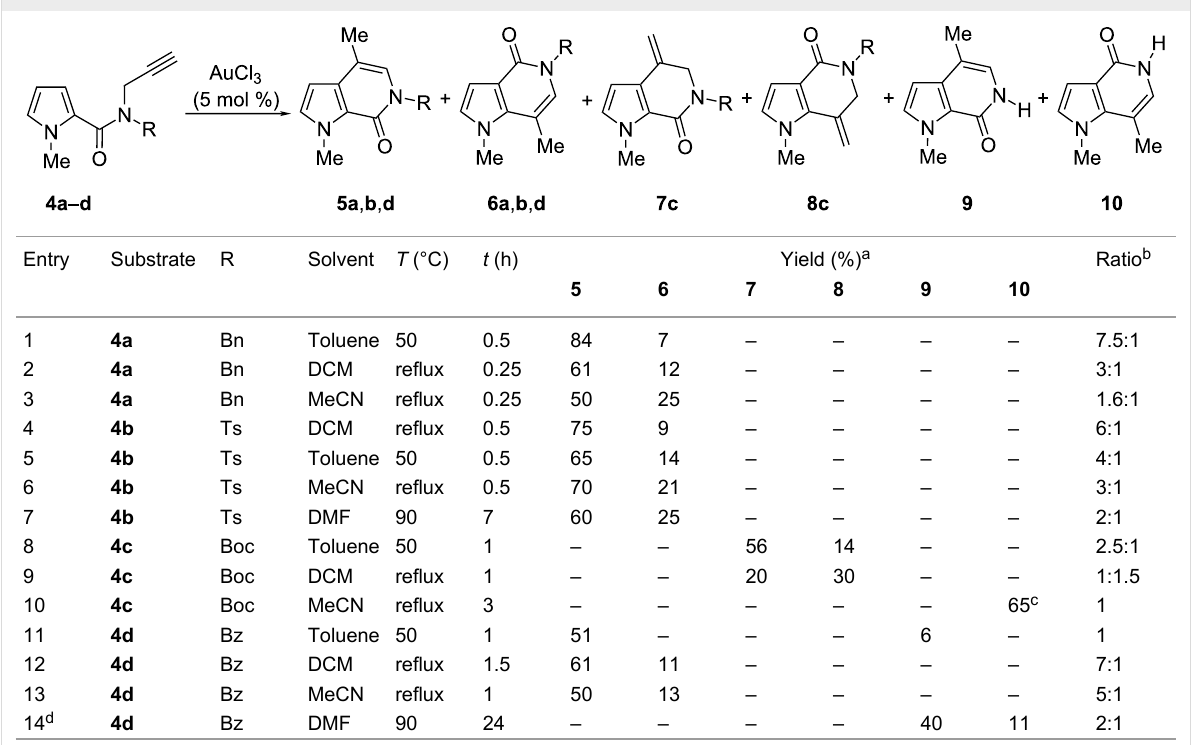
Table 3: Scope of the reaction on differently N -substituted N -propargyl pyrrole-carboxamides.